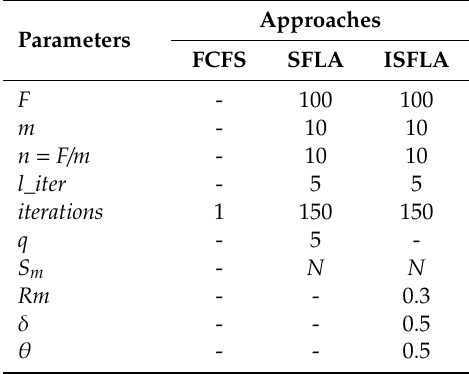
Table 1. Parameter values for di ff erent